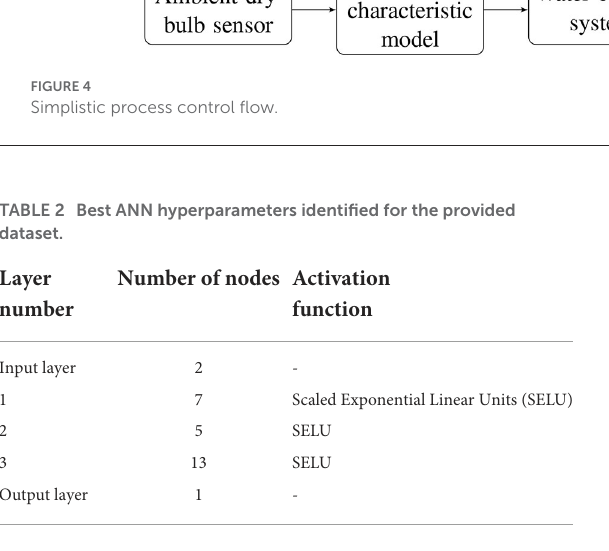
validation data. Using the optimal parameters in Table 3, the RMSE for testing data was 0.72 ◦